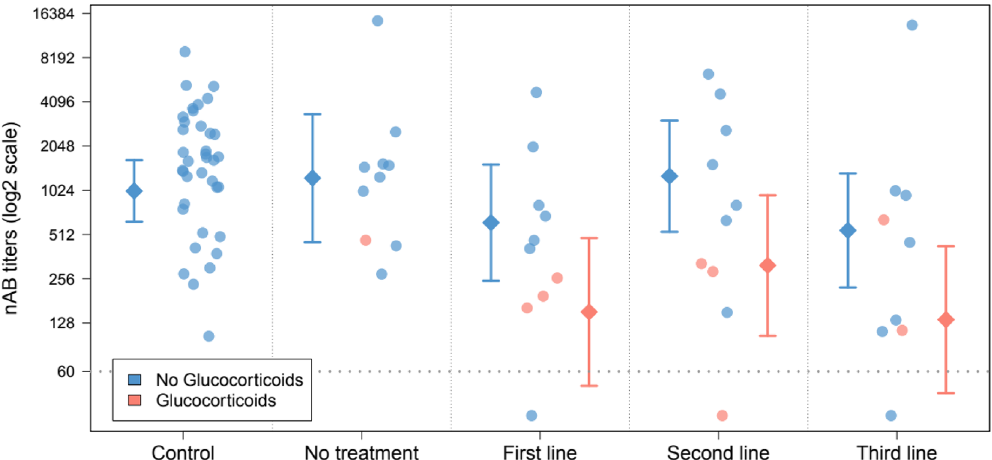
Figure 1. Neutralizing antibody (nAB) titre after SARS-CoV-2 vaccination in Healthy individuals (Controls) and Systemic Lupus Erythematosus (SLE) patients under different therapy regimens. Diamond-shaped symbols and their associated segments represent adjusted means and 95% confidence intervals of antibody titres. Estimations are derived from a linear model in which sex, age, time from vaccination, vaccine type and corticoids therapy were included as covariates for statistical control. Antibody titres were log2-transformed in order to fit the assumptions of the model and are represented in log2-scale. The horizontal dotted line indicates the detection threshold for the determinations (60). The estimation of the decrease in nAB titres in Lupus patients associated to Glucocorticoids therapy is 75% (Fold-Change = 0.25, 95% Confidence Interval = 0.10–0.63, p =